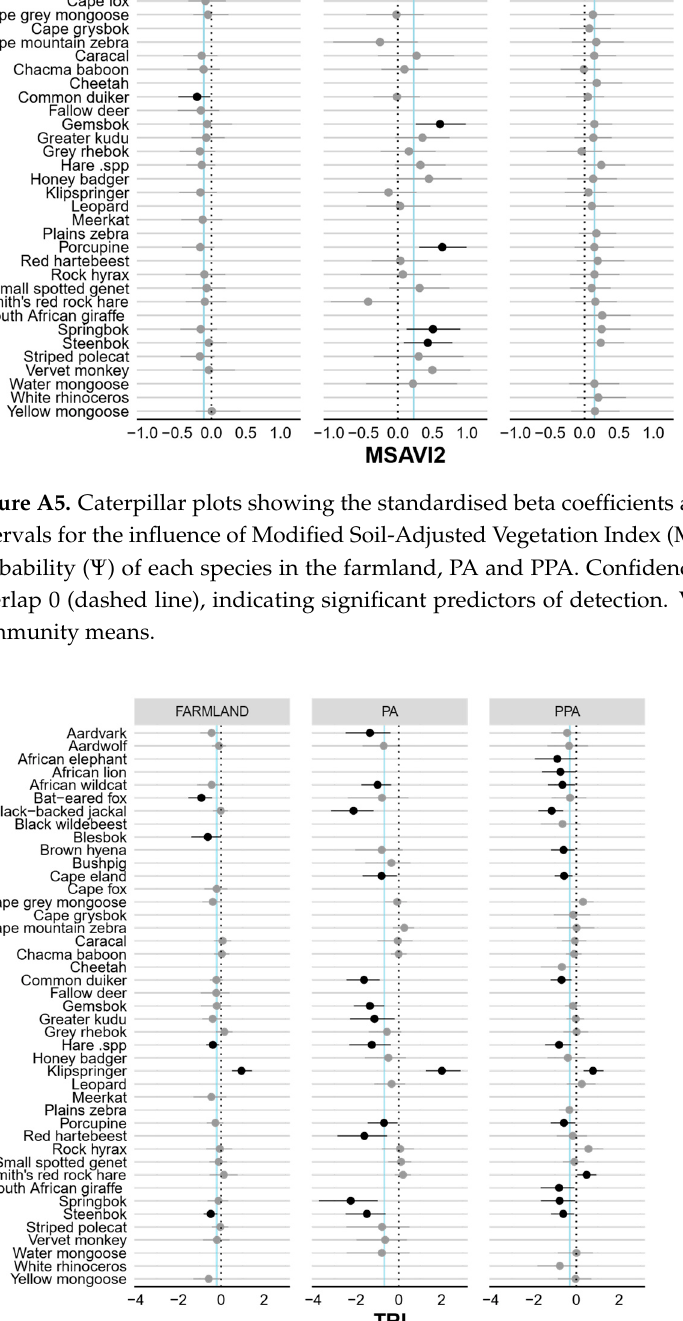
Figure A6. Caterpillar plots showing the standardised beta coefficients and 95% Bayesian credible intervals for the influence of terrain ruggedness (TRI) on the occurrence probability ( Ψ ) of each species in the farmland, PA and PPA. Confidence intervals in bold do not overlap 0 (dashed line), indicating significant predictors of detection. Vertical blue lines indicate community means.